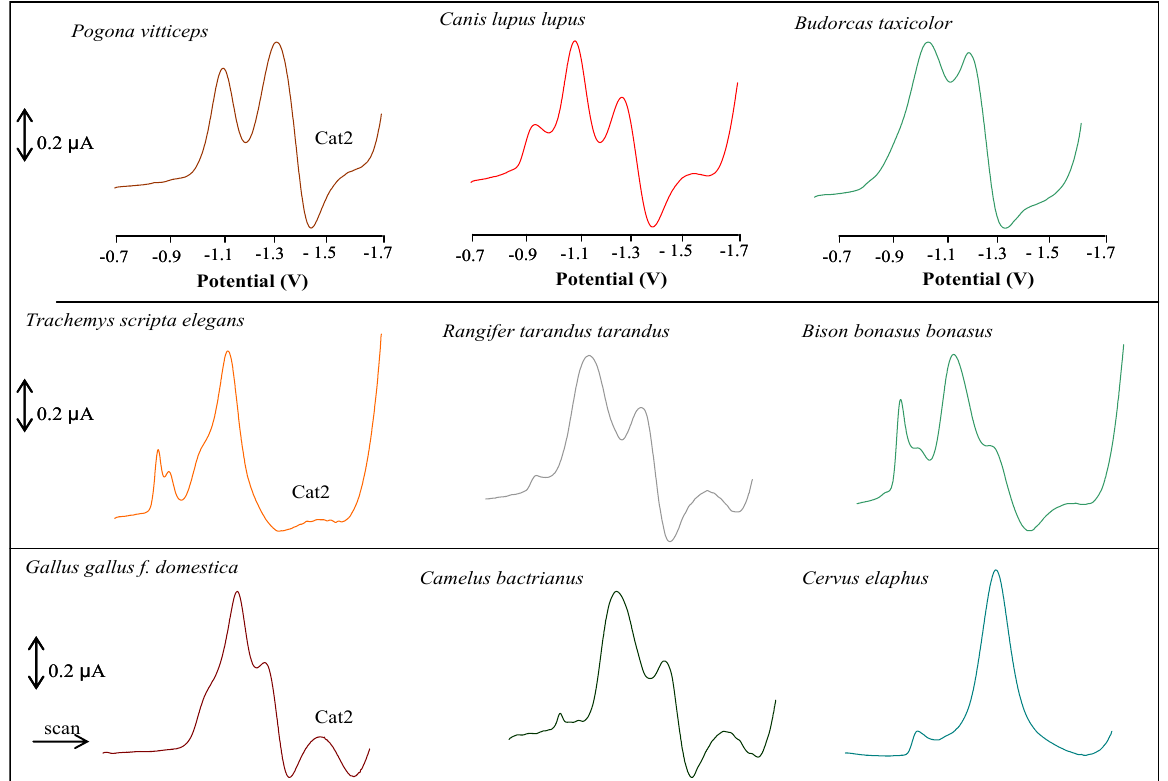
Figure 3. Characteristic voltammograms of blood plasma samples of nine animal species